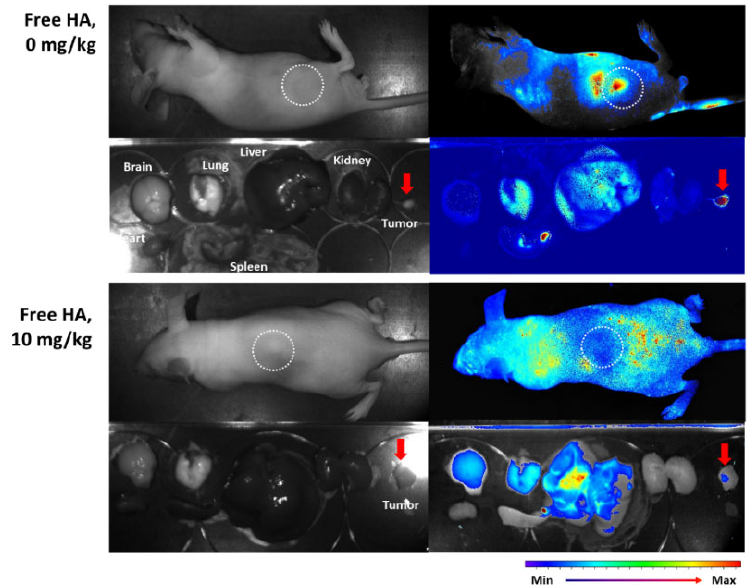
Figure 8. In vivo tumor imaging of HeLa tumor-bearing mice. Thirty minutes before administration of nanophotosensitizers, free HA (10 mg/kg) was i.v. administered, via tail vein, to mice. Then,